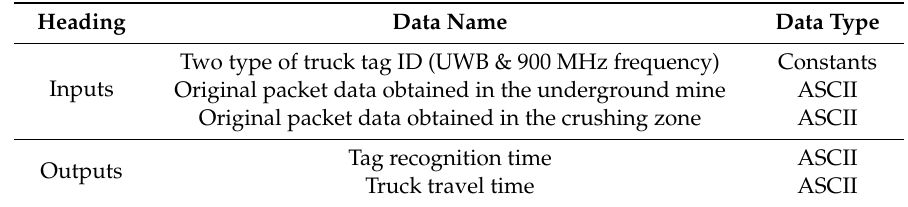
Table 2. Description of the input data and output data of the program developed for measuring truck travel data.